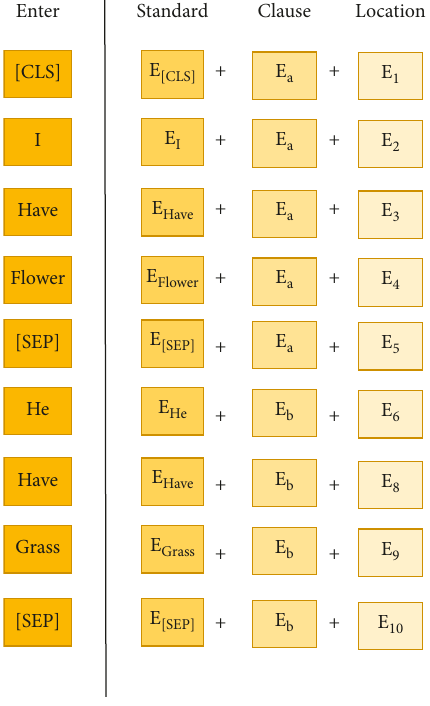
Figure 2: BERT word embedding